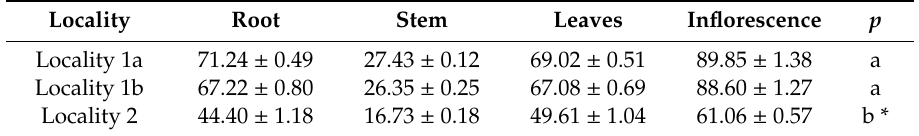
Table 1. Total phenolic content in the di ff erent parts of I. helenium (mg of gallic acid (GA) /